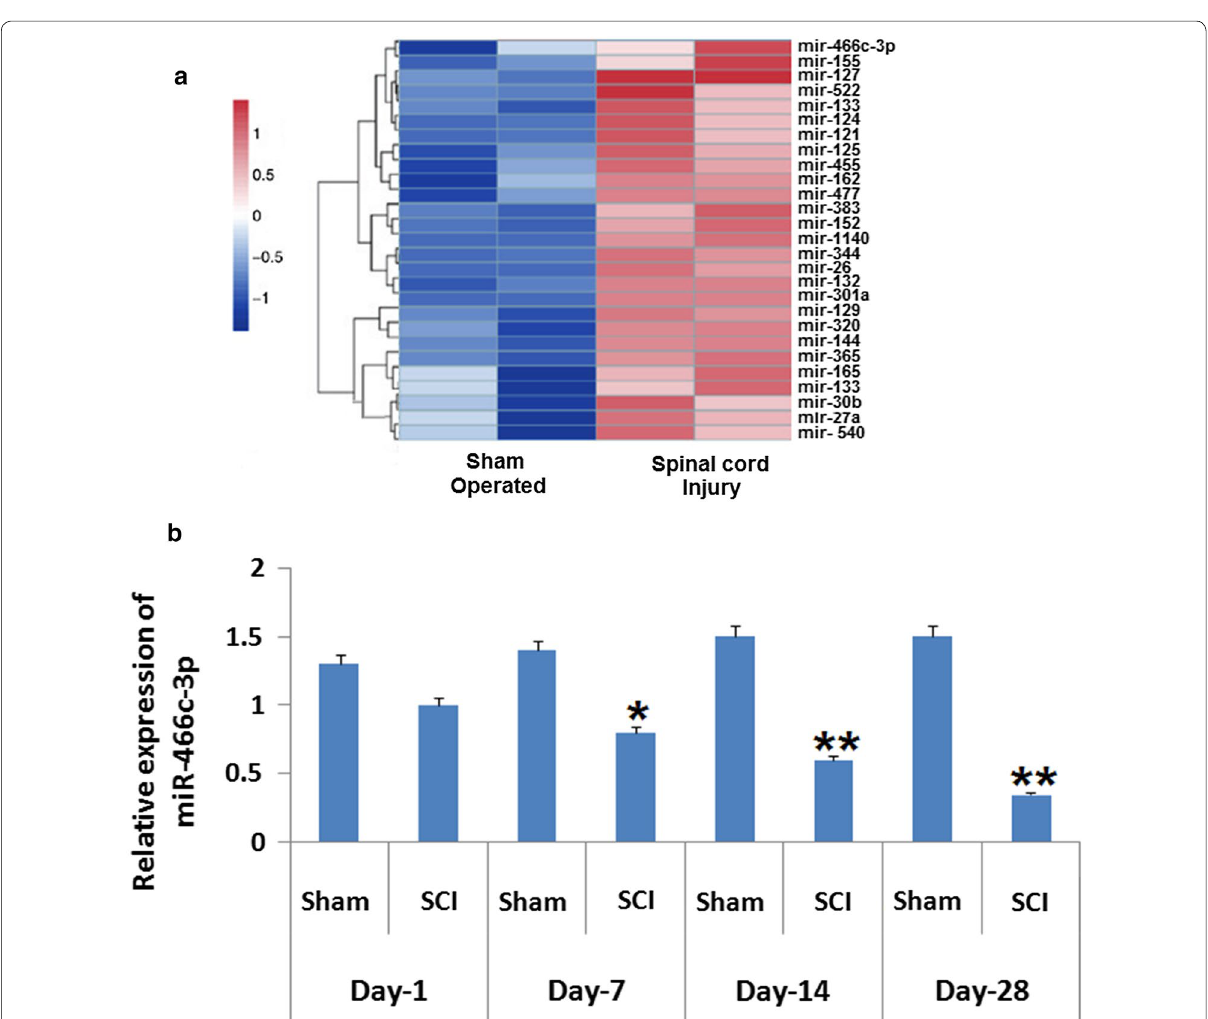
Fig. 1 Expression of miR in rats subjected to spinal cord injury. a Outcomes of heat map analysis showing significant changes in expression of miRs in rats after 14 days subjecting them to spinal cord injury. The blue color shows suppression and red shows over-expression. b Quantitative results of reverse transcription by qRT-PCR for determining the expression of miR-466c-3p in the spinal cord tissues of rats isolated on the 1st, 7th, 14th and the 28th day after inducing spinal cord injury. The results are presented mean SD. *P < 0.05, **P < 0.01 compared to sham operated ±